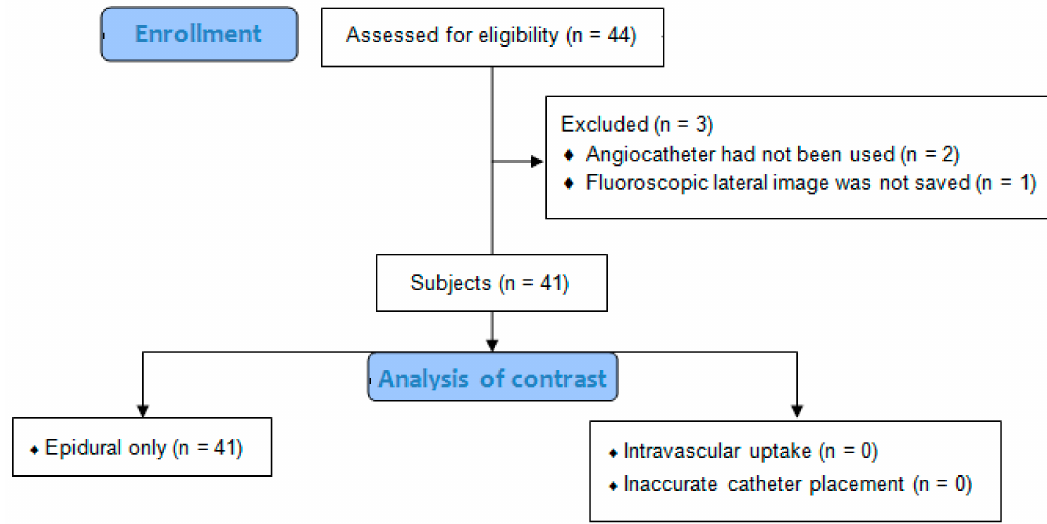
Figure 2. Flow diagram of the study.